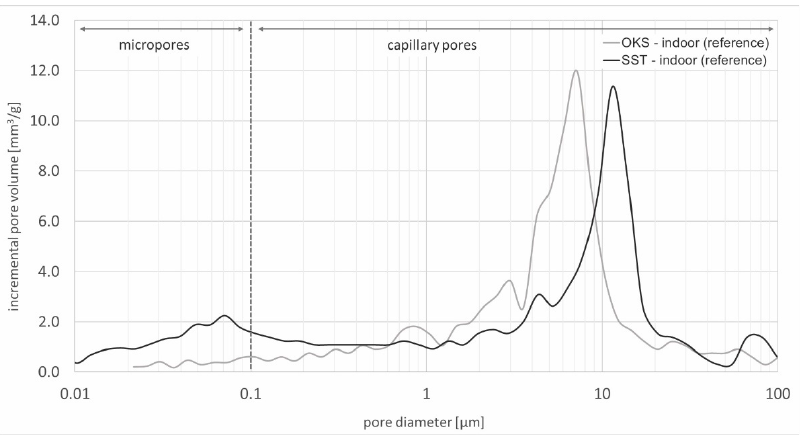
Figure 2. Pore size distribution of the Obernkirchener and Schleeriether Sandstones stored indoors (reference).